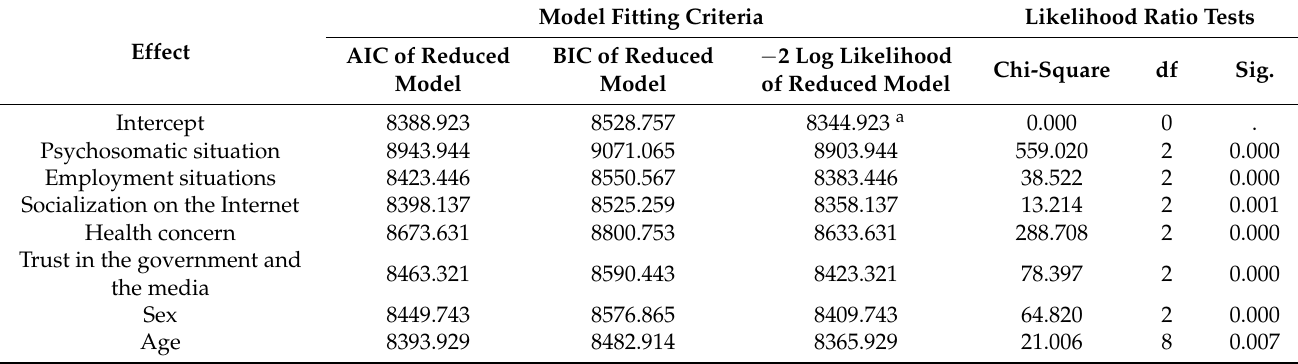
Table A2. Life satisfaction during and before lockdown, likelihood ratio tests—accepted